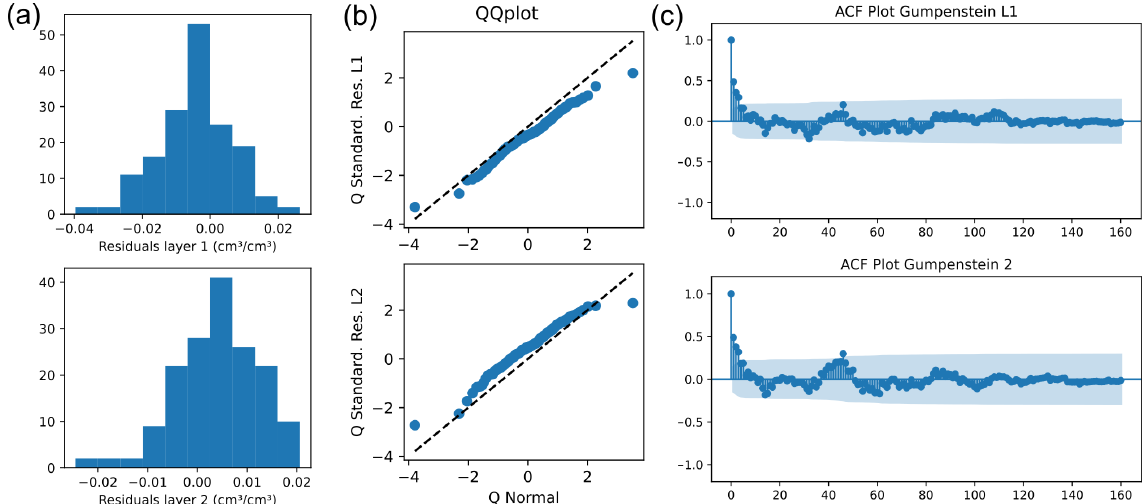
Figure A1. Residual plots for the calibration at Gumpenstein: (a) histogram of residuals, (b) quantile–quantile (QQ) plots, and (c) autocor- relation function (ACF) plots. The upper graphs show residuals of the upper soil layer (L1) and the lower graphs show residuals of the lower soil layer